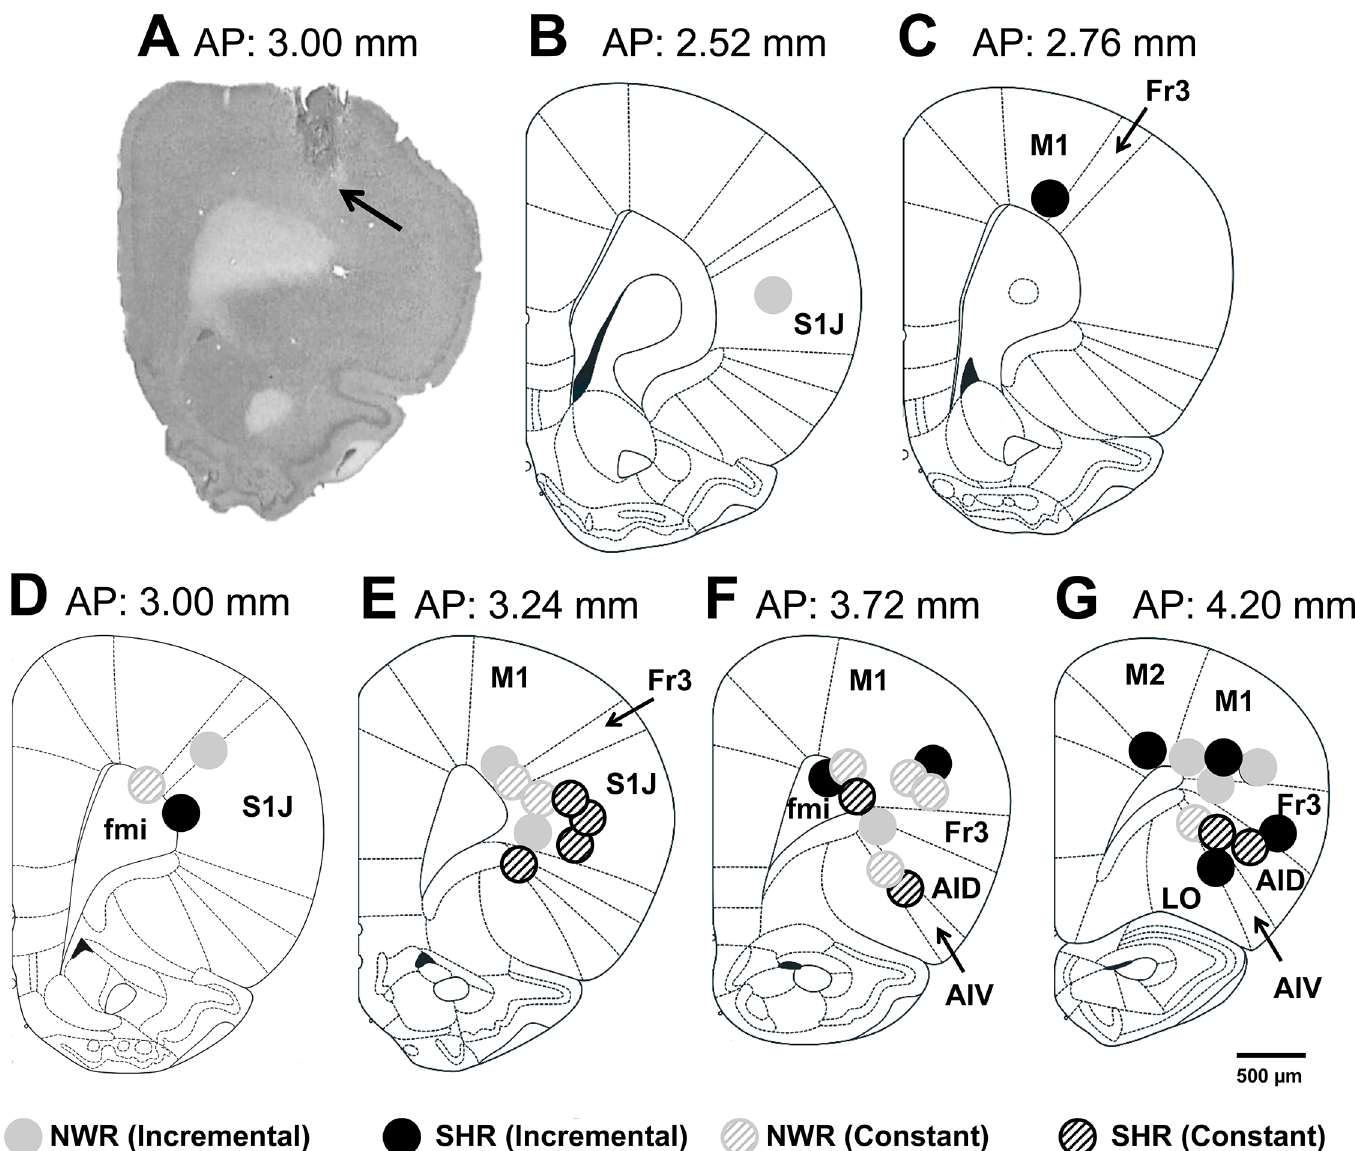
Fig 1. Thermistor tip positions in the brain. (A) Photomicrograph of a brain tissue section (50 μ m) that was stained with cresyl violet. (B-G) Schematic drawings taken from Paxinos and Watson ’ s atlas (2007) showing the thermistor tip locations in the rat brain used in this study. Legend: The black arrow indicates the lesioned region. AID, agranular insular cortex, dorsal part; AIV, agranular insular cortex, ventral part; DI, dysgranular insular cortex; fmi, forceps minor of the corpus callosum; Fr3, frontal cortex, area 3; LO, lateral orbital cortex; M1, primary motor cortex; and S1J, primary somatosensory cortex, jaw